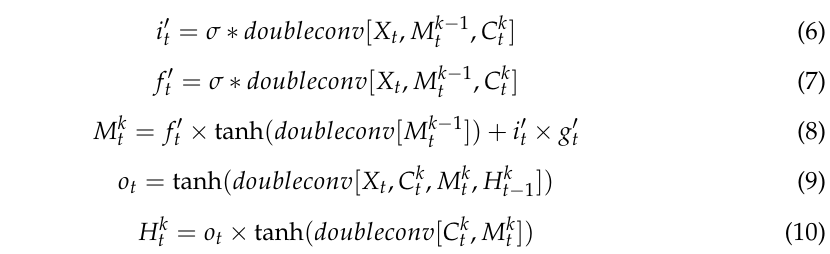
t S − Figure 6. GHU structure. The equations of the GHU can be presented as follows: